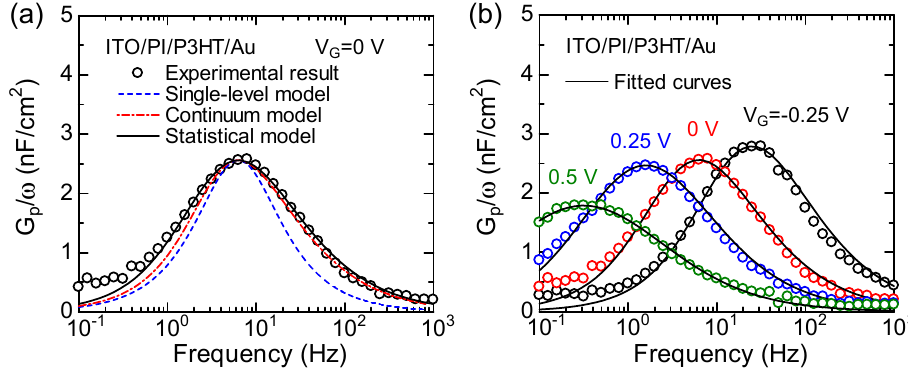
Figure 7. ( a ) Plot of the equivalent parallel conductance loss ( G p / ω ) versus frequency for the P3HT MIS capacitor with the PI gate insulator at a gate voltage ( V G ) of 0 V. The dashed blue line, dashed-dotted red line, and solid black lines represent the fitted results using Equations (3), (4) and (7), respectively. ( b ) Fitted results for the frequency dependence of G p / ω of the ITO/PI/P3HT/Au MIS capacitor at different gate voltages using the statistical model.